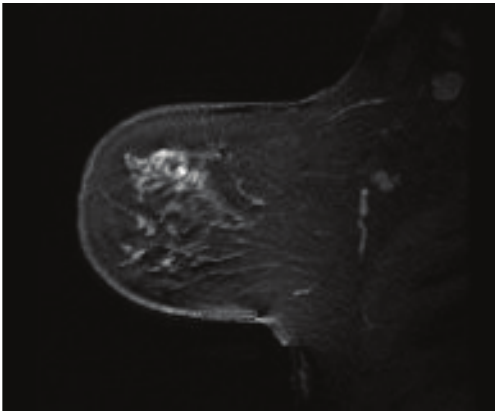
Figure 1: MRI appearance of recurrent DCIS.